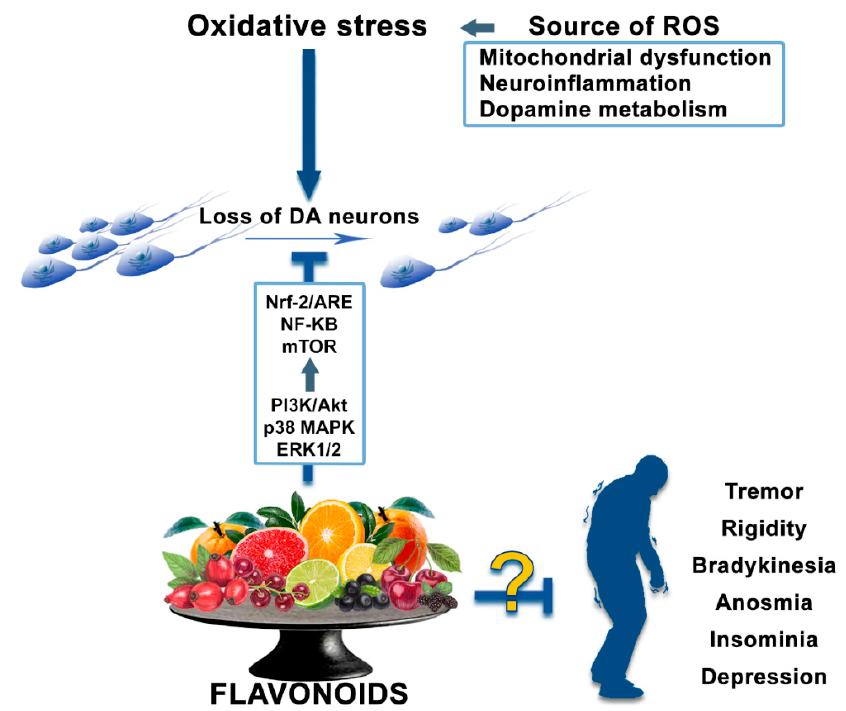
Figure 3. The potential of flavonoids as alternative therapeutic agents against Parkinson’s